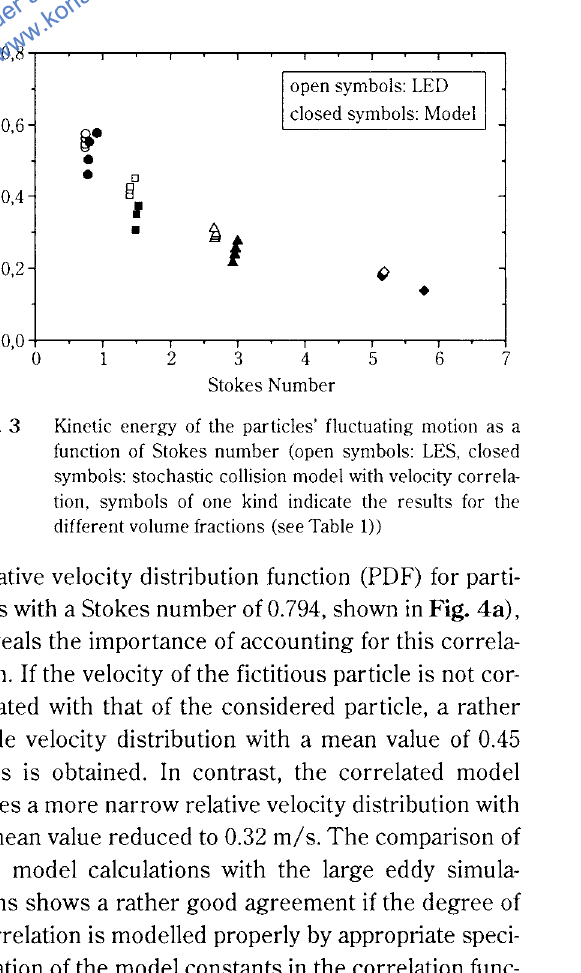
Distribution of the relative velocity between colliding particles (a) and the particle-particle collision angle (b), comparison of the stochastic model with large eddy